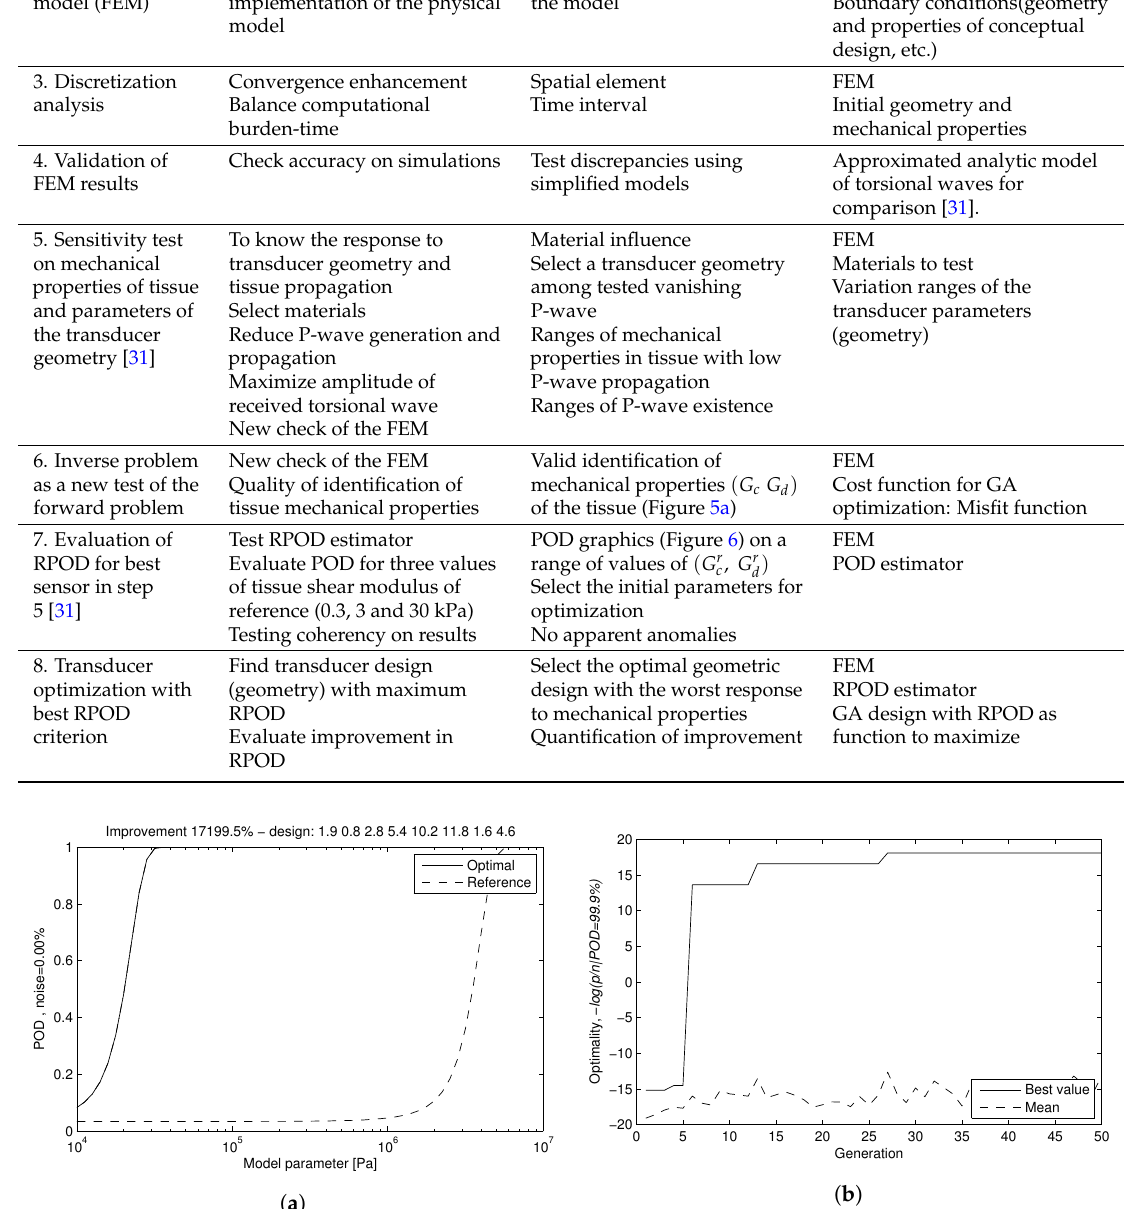
Figure 5. Result of the RPOD optimization process in phase 2. ( a ) RPOD functions of the optimized transducer design and the reference design; ( b ) evolution through generations; best design captured in 27th